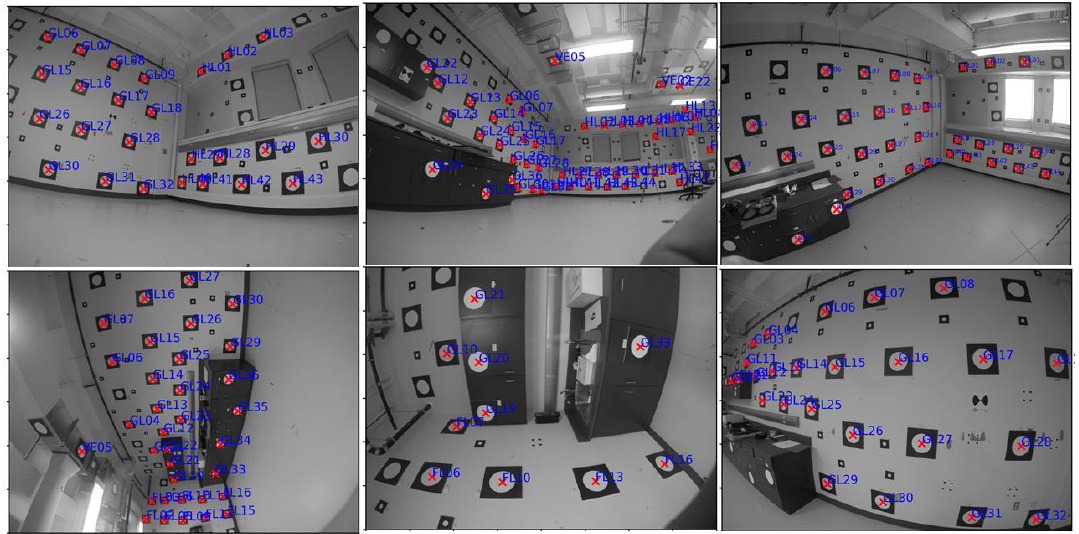
Figure 7. Selection of images from GoPro Hero5 with detected and labelled